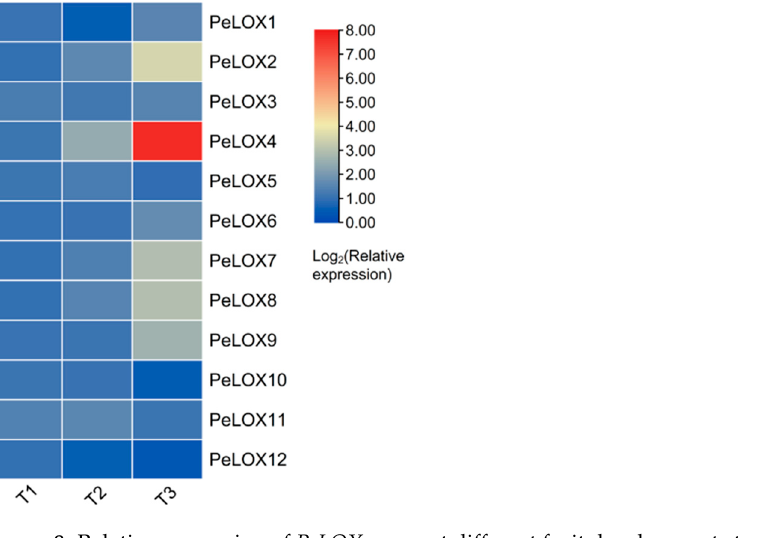
Figure 8. Relative expression of PeLOX genes at different fruit development stages from passion fruit via qRT-PCR.